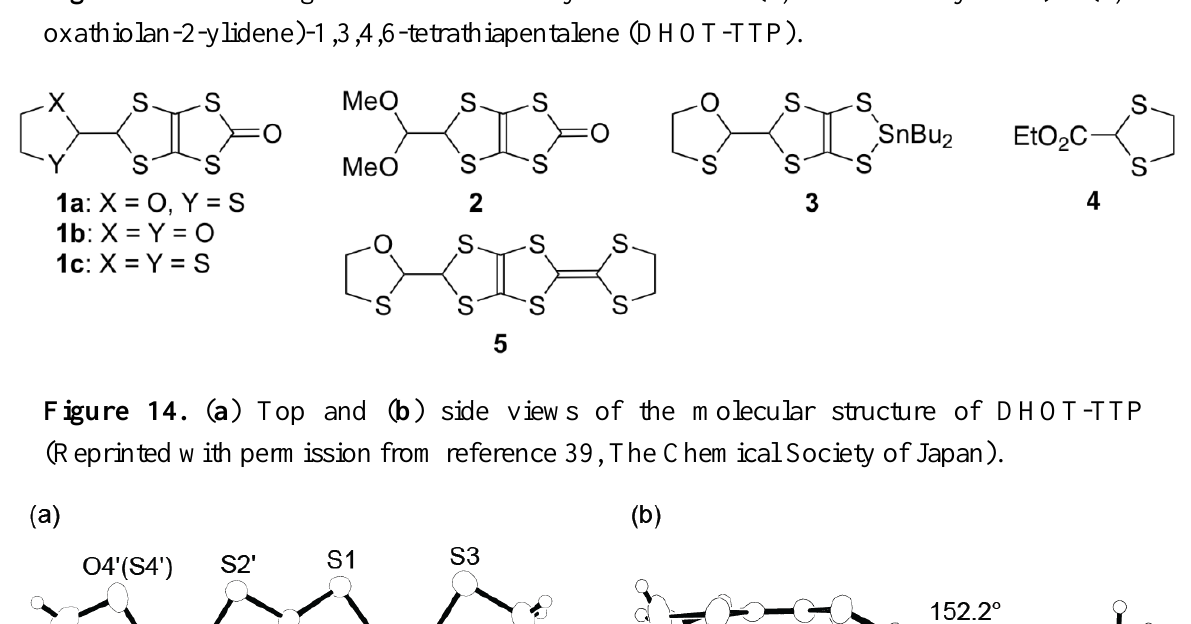
Figure 13. Building blocks for the synthesis of 2-(1,3-dithiolan-2-ylidene)-5-(1,3-